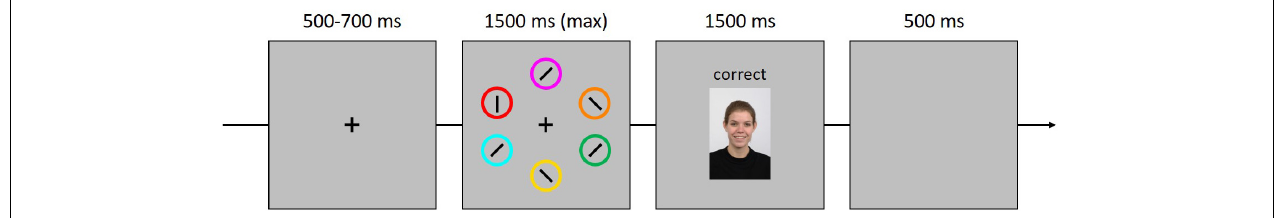
FIGURE 1 | Example trial in the social reward association phase. Participants reported with a keypress the orientation of the bar within targets defined by their color (e.g., red in this case). Correct responses were followed by a feedback consisting of the presentation of a neutral or happy face (here, happy) from the Radboud Faces database (Langner et al., 2010). One target color was associated with a greater probability of a happy face vs. a neutral face (80 – 20%), while for the other target color this ratio was